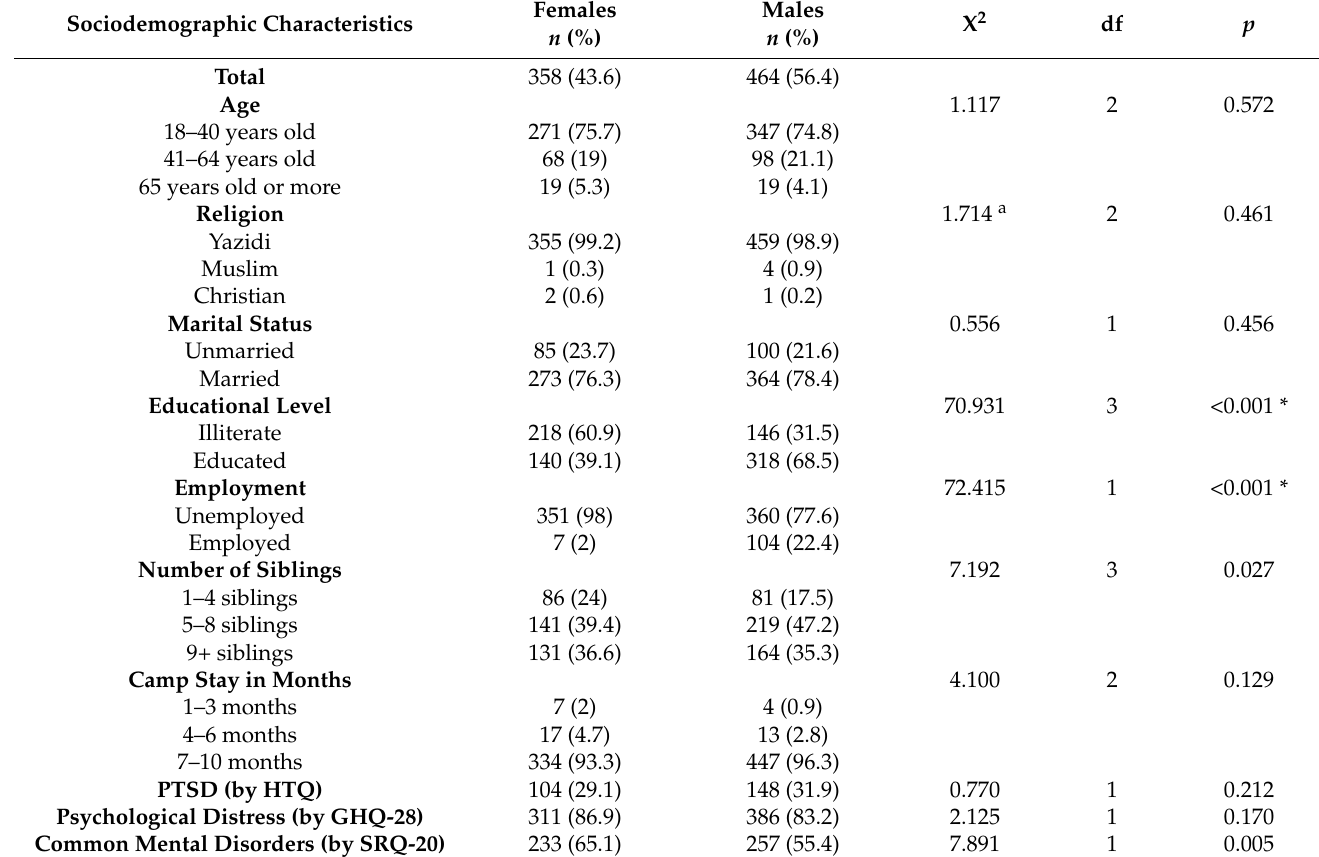
Table 1. Sociodemographic characteristics and PTSD and psychological distress prevalence rates according to gender. ( n =